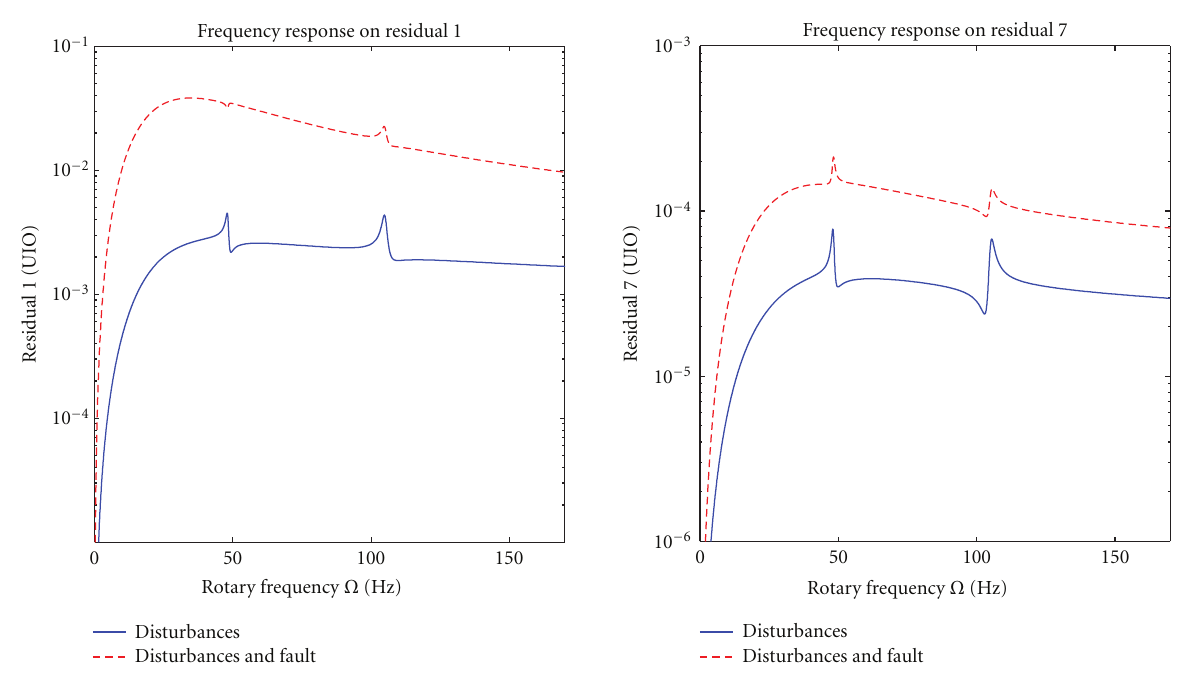
Figure 7: Frequency response of disturbances and fault on the residuals generated by unknown input observer.